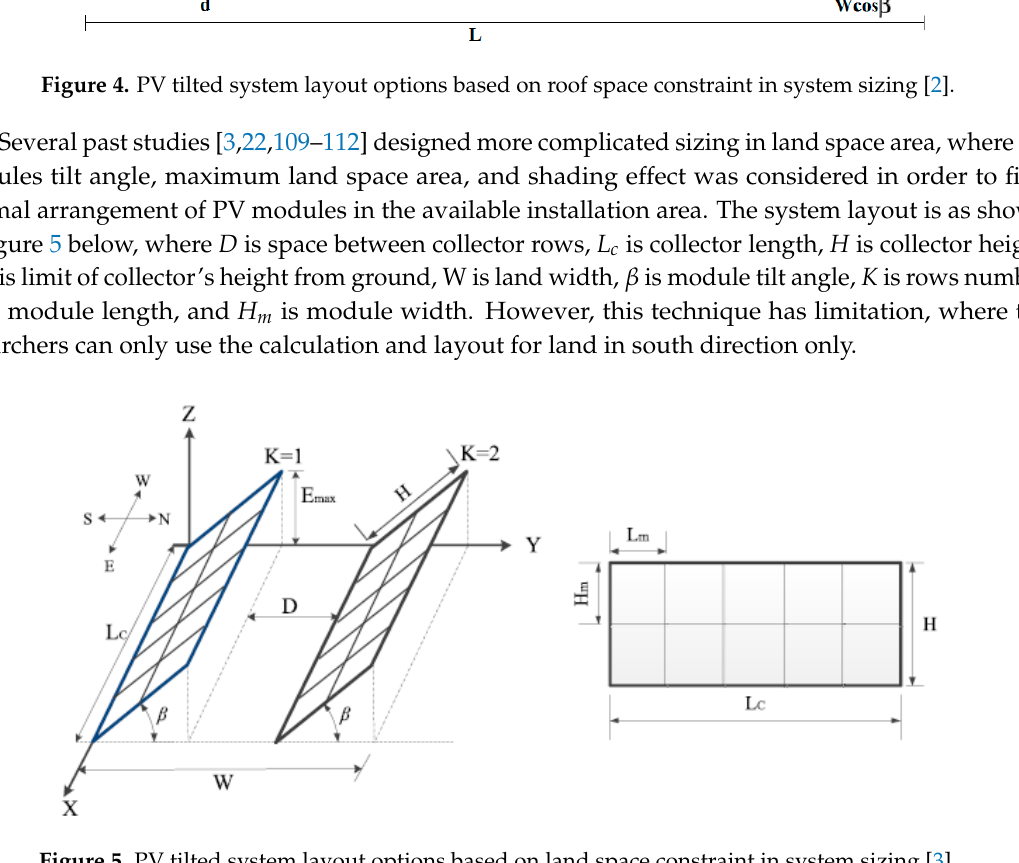
Figure 3. PV system layout options based on roof space constraint in system sizing [2].